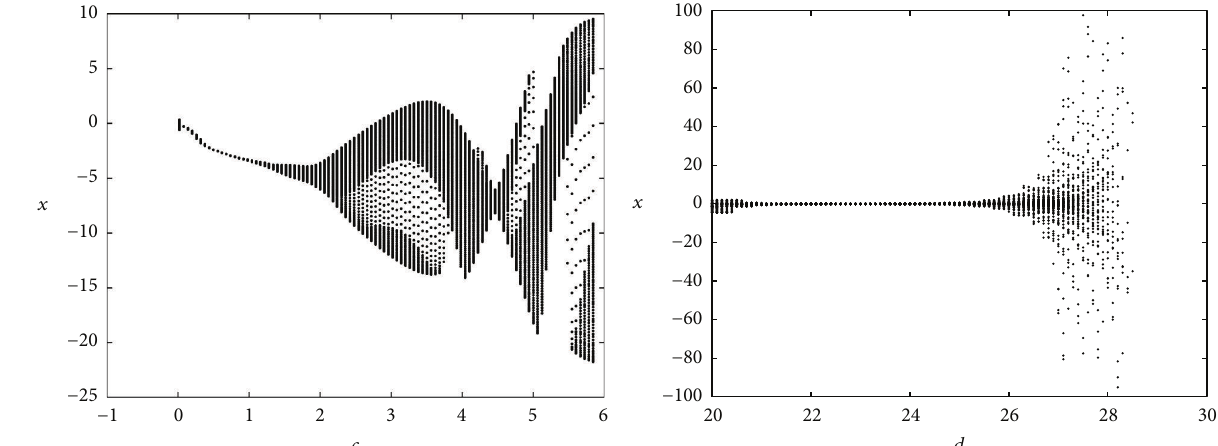
(b) Bifurcation diagram with the change of 𝑏 with the rest fixed parameters